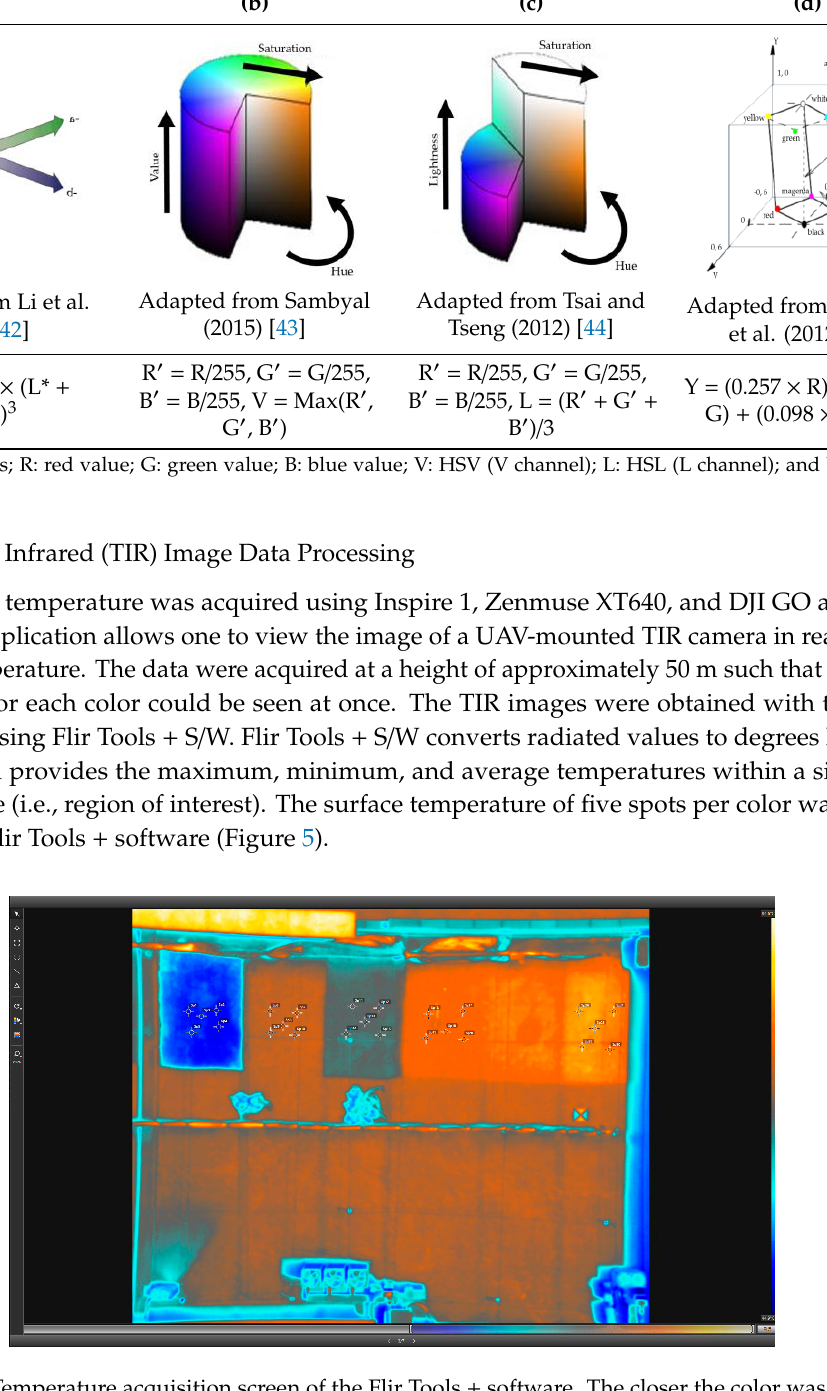
Figure 5. Temperature acquisition screen of the Flir Tools + software. The closer the color was to red, the higher the temperature. The closer the color was to blue, the lower the